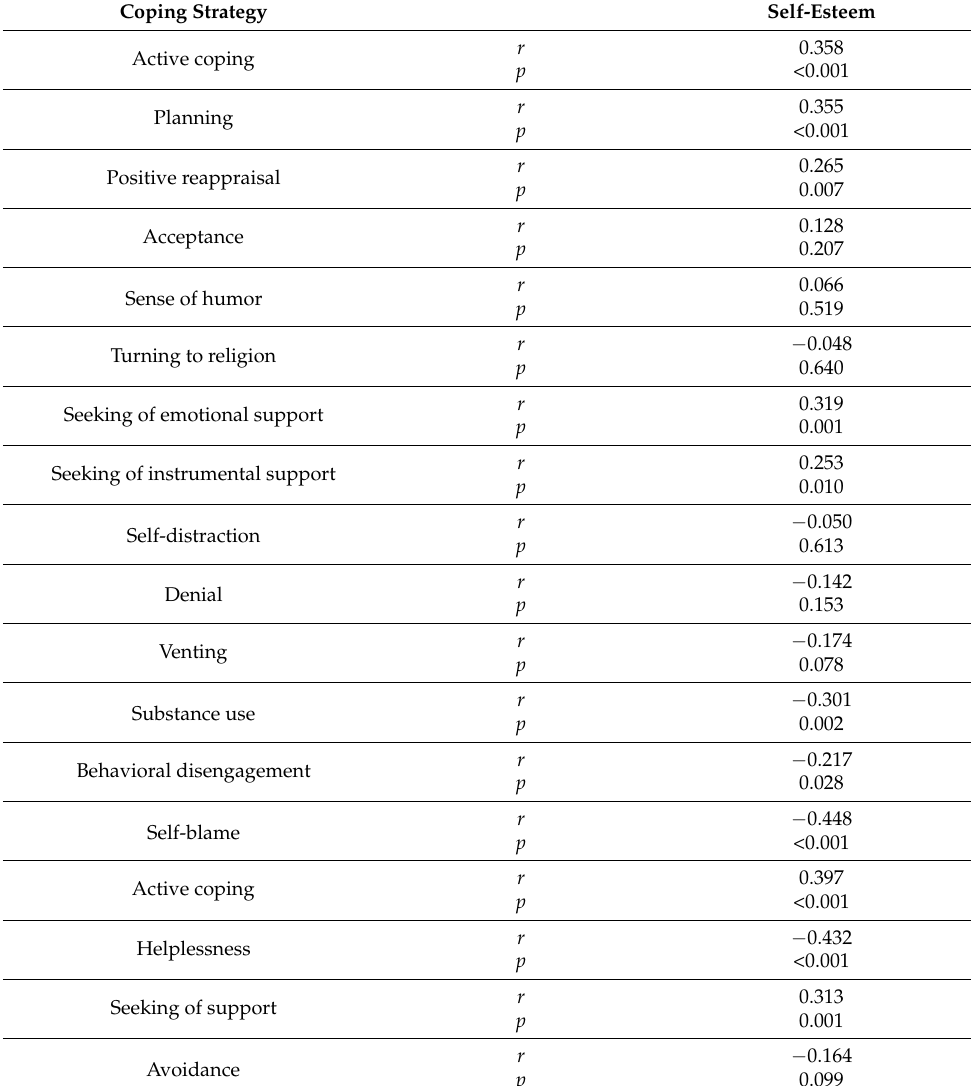
Table 5. Relationship of self-esteem and coping strategies; r —Pearson’s correlation coefficient. p — significance